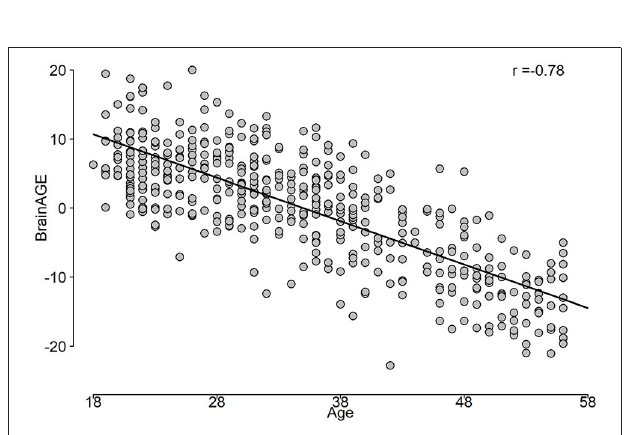
FIGURE 6 | The BrainAGE variable as a function of the chronological age.